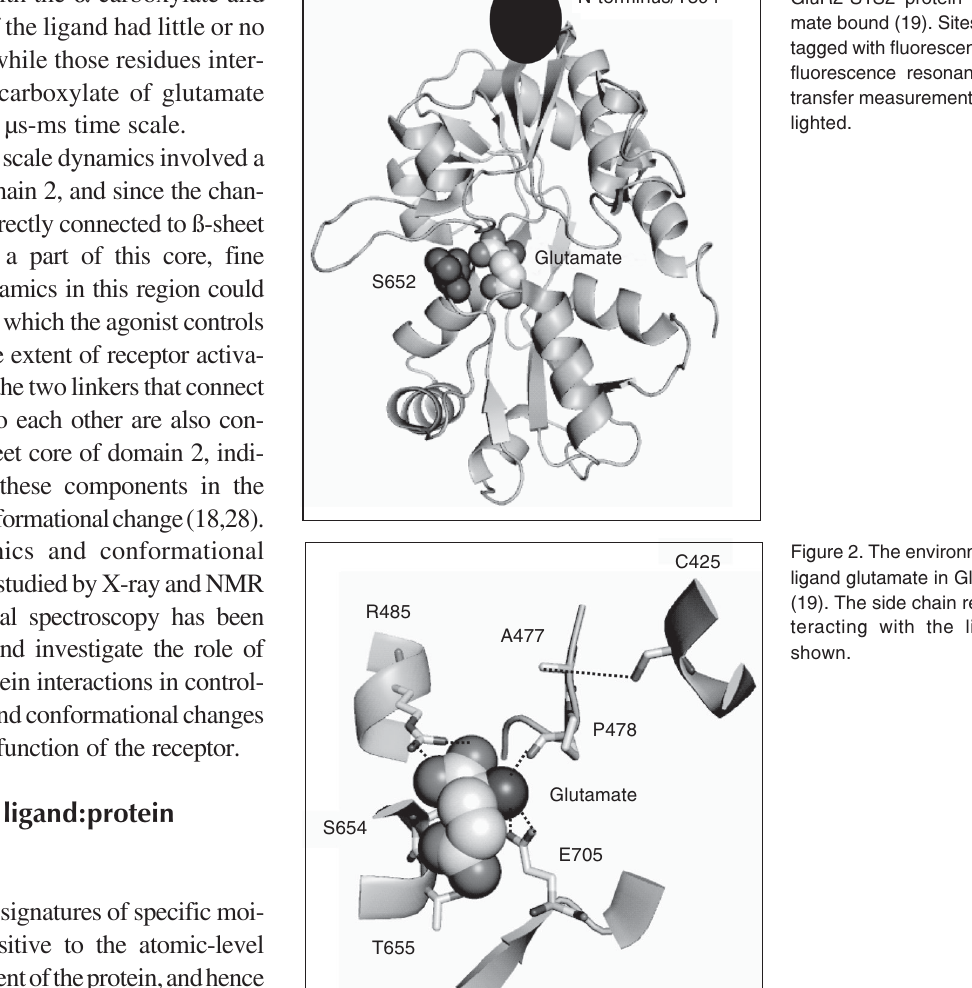
Figure 1. Crystal structure of GluR2-S1S2 protein with gluta- mate bound (19). Sites that were tagged with fluorescent labels for fluorescence resonance energy transfer measurements are high-